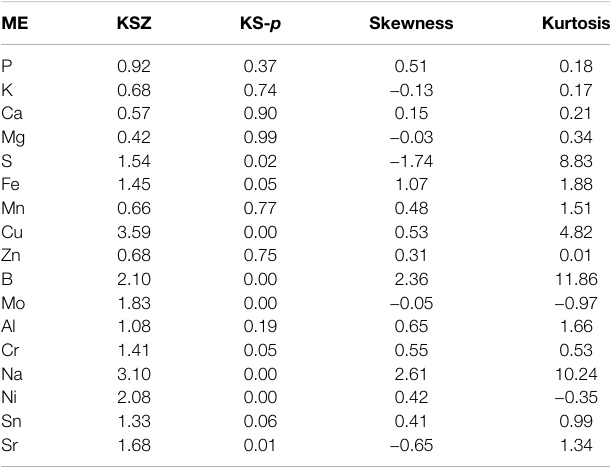
TABLE 2 | The statistical analysis (Skewness and Kurtosis) for normal distribution test of mineral elements and their results in Near-isogenic lines (NILs) of Towada brown rice.